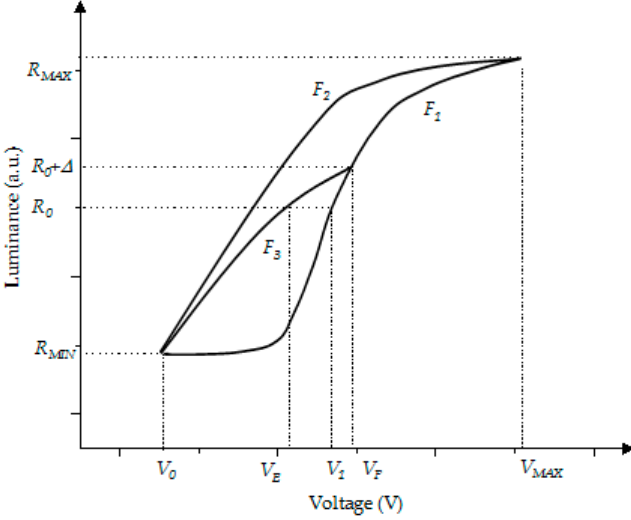
Figure 4. Design of driving waveform voltage amplitude in amplitude–frequency mixed modulation.